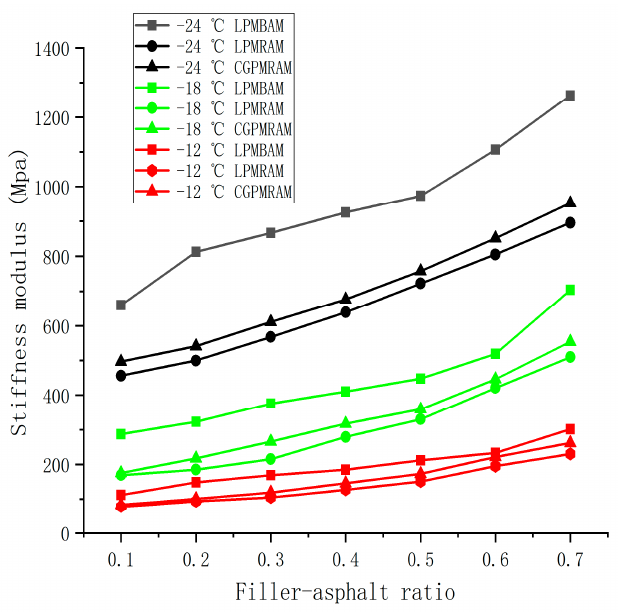
Figure 7. Sti ff ness modulus S of mortar at di ff erent temperatures and fi ller-asphalt ratios. Figure 7. Stiffness modulus S of mortar at different temperatures and filler-asphalt